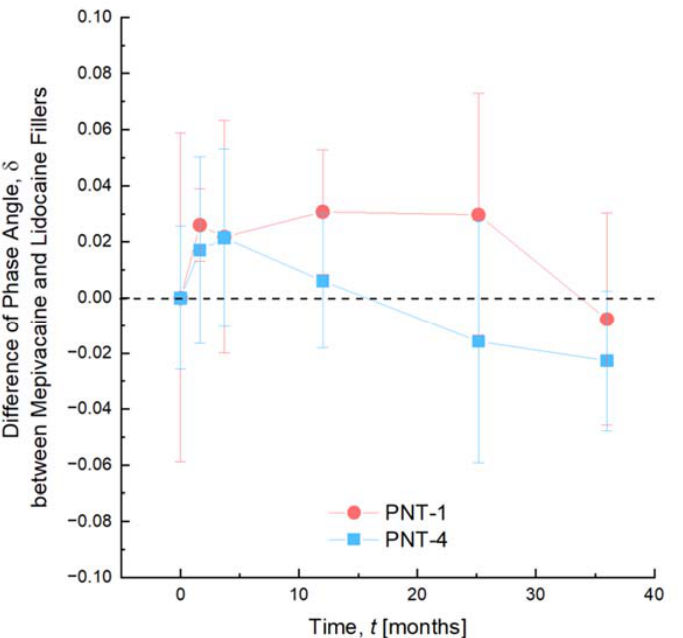
Figure 1. Shelf-life stability of PNT-1 and PNT-4 in the presence of lidocaine and mepivacaine over 3 years. The difference of phase angle between mepivacaine and lidocaine groups was monitored.